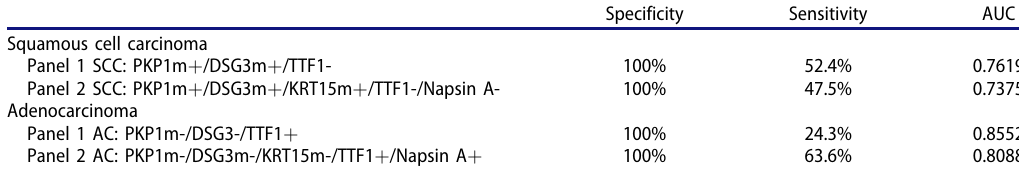
Stepwise multivariate logistic regression model A stepwise multivariate logistic regression model was con- structed to determine the optimal immunohistochemical marker panel for differentiating between SCC and AC. The best result included the combination of markers CK5/6, p63, and PKP1 in membrane, giving a percentage correct classifi-